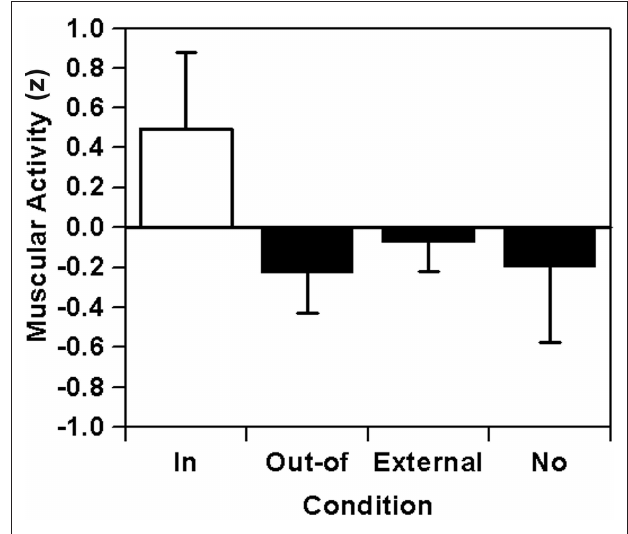
(no).Figure 8 | Basketball free throws: spatial compensation combined across the two nodal points as a function of focus of attention on the nodal point (in-focus), on the other nodal point (out-of-focus), on the basket (external), or without any special instruction